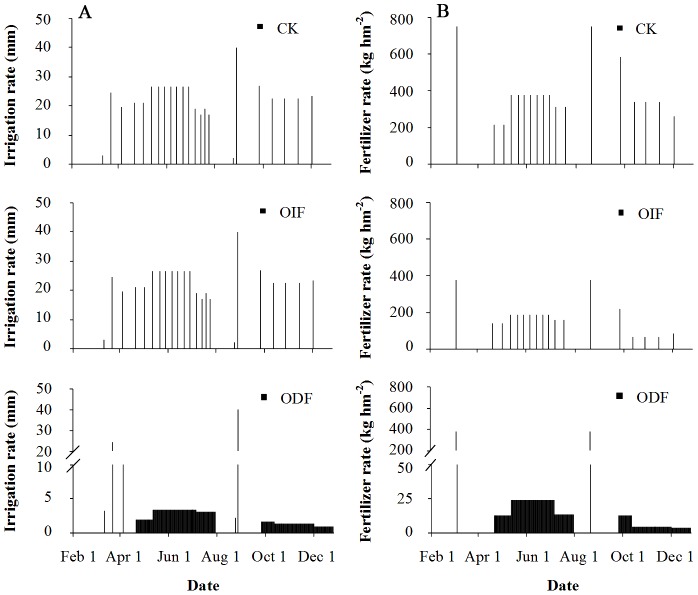
Irrigation scheduling (A) and fertilization scheduling (B) under three different fertigation ways in a solar greenhouse cucumber cultivation system.All fertilizer varity were compound fertilizer. The two N:P2O5:K2O formulations of basal fertilizer were respectively (18∶46∶0) and (15∶15∶15) during ES and AW seasons. The three N:P2O5:K2O formulations of topdressing fertilizer were respectively (20∶20∶20), (19∶8∶27) and (18∶6∶34) for early fruit stage, middle fruit stage, late fruit stage during ES and AW seasons.